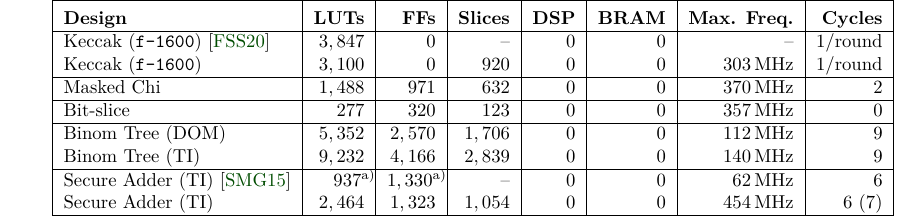
Figure 11: Secure Kogge-Stone adder ( SecAdd ) for 4-bit additions. Table 4: Resource and performance overview for the non-linear accelerators (measurements of this work evaluated for Artix 7 FPGA